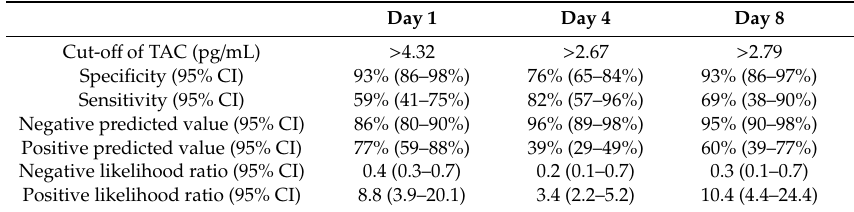
Table 2. Thirty-day mortality prognostic capability of serum total antioxidant capacity (TAC) levels at day 1, 4, and 8 of trauma brain